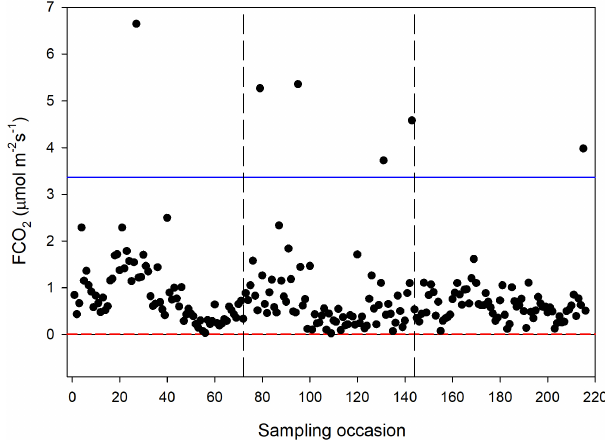
Figure 4. Measured CO 2 exchange (FCO 2 ) from the 24 sampling points using a dark chamber and portable gas analyzer. The dashed red line indicates the CO 2 flux detection limit, and the blue line rep- resents 3 × SD of all data points. The dashed vertical lines separate sampling periods from left to right: 14–15 June, 26 June–2 July and 25–27 August, respectively.